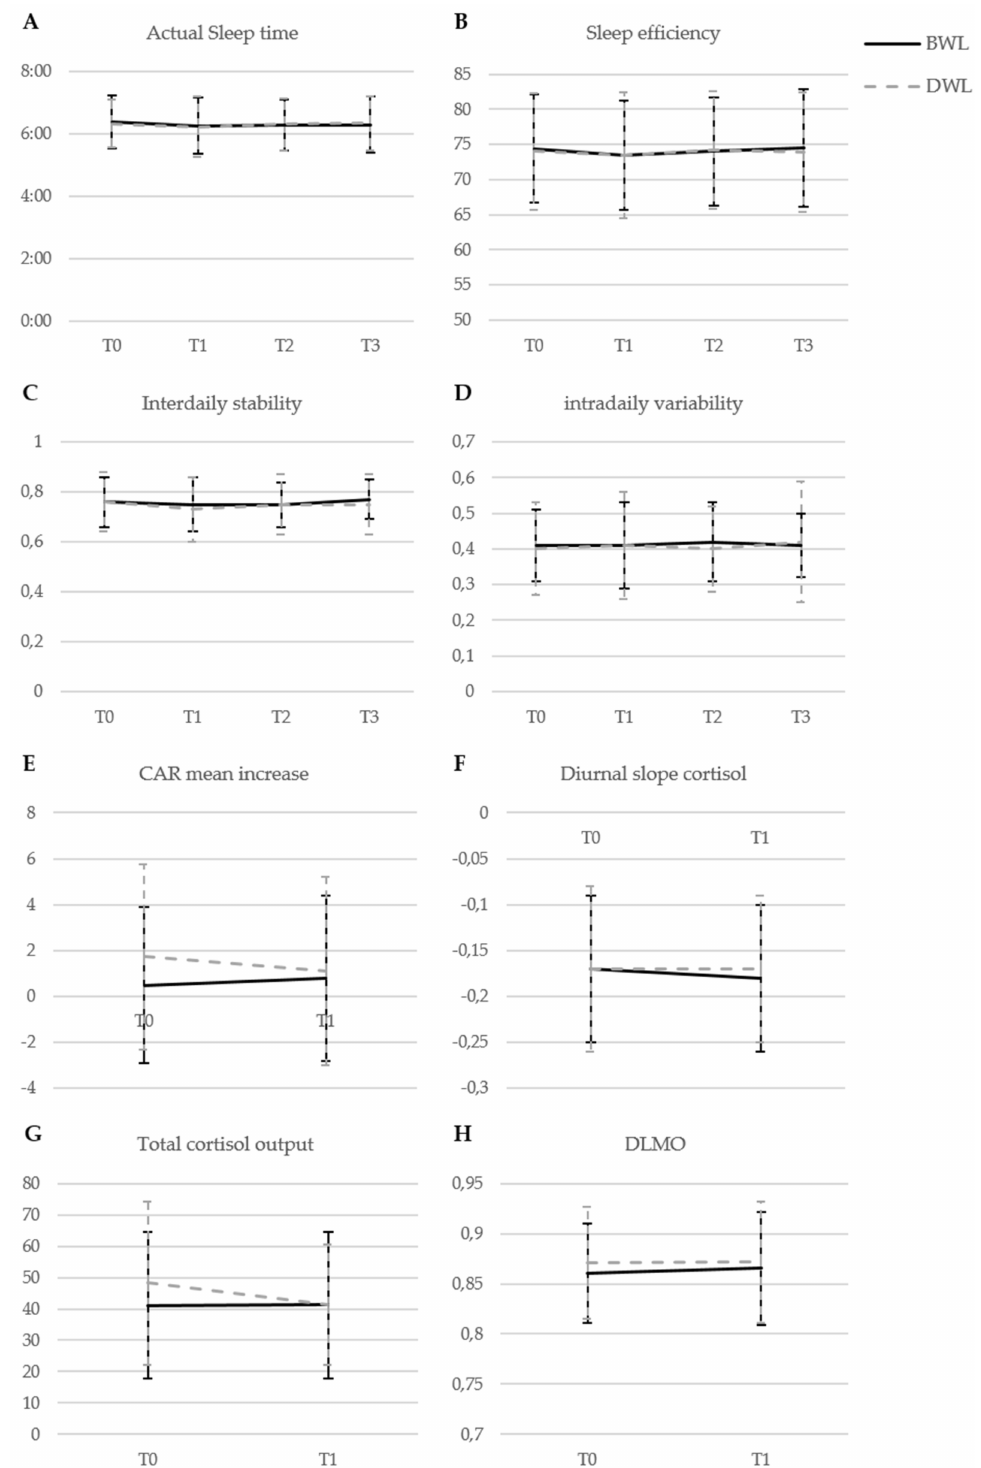
Figure 3. Changes in raw mean levels of actigraphy-derived sleep variables ( A – D ), cortisol, and melatonin variables ( E – H ) in groups receiving bright white light therapy (BWL; n = 83) and dim white light therapy (DWL; n = 83). Bars indicate standard deviations. Abbreviations: BWL, bright white light; CAR, cortisol awakening response; DLMO, dim light melatonin onset; DWL, dim white light; T0, baseline; T1, directly post-intervention; T2, 3 months after the end of light therapy; T3, 9 months after finishing light